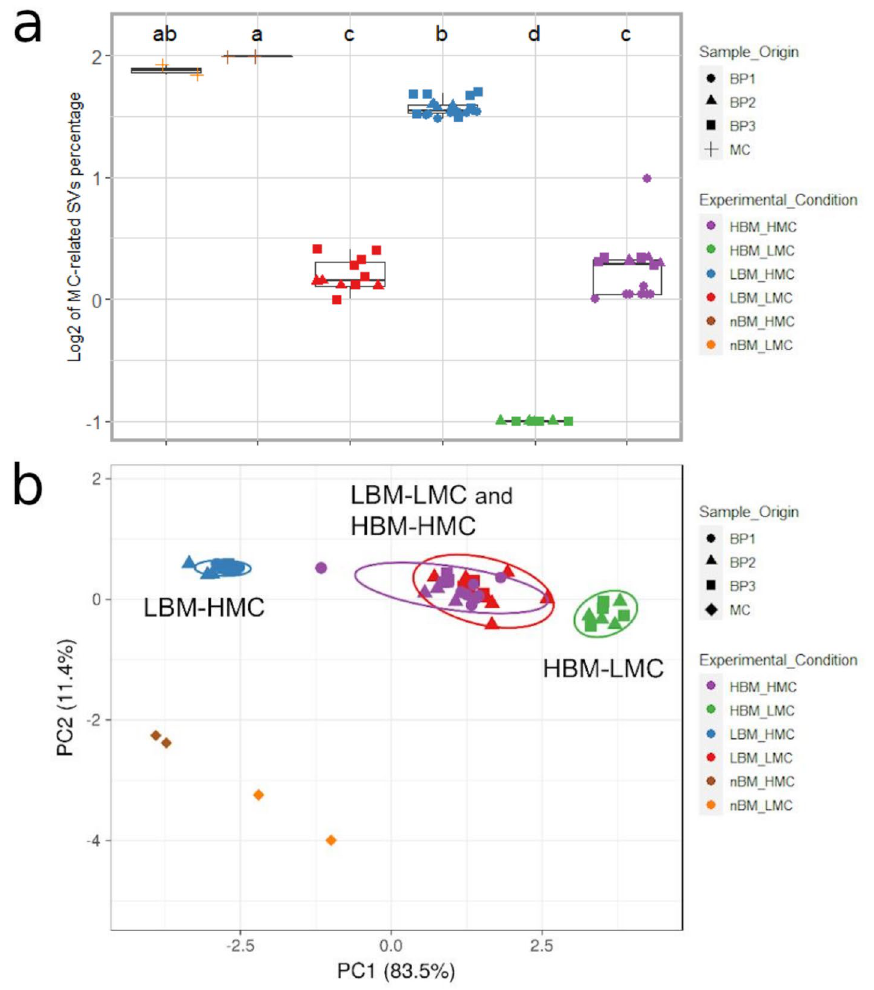
Figure 2. Clustering of samples based on the relative abundance of MC-SVs. ( a ) PCA of MC-SV sequence abundance. Original values were ln(x + 1)-transformed. Unit variance scaling is applied to rows; Singular value decomposition with imputation is used to calculate principal components. 95% prediction ellipses are shown for each combination of sample biomass and MC dose. ( b ) Proportion of MC-SVs compared to total SVs in each library. Results from Tukey HSD test on the ANOVA results indicated by ( a – d